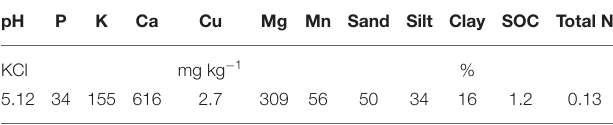
TABLE 1 | Selected properties of soil used in the pot study. pH P K Ca